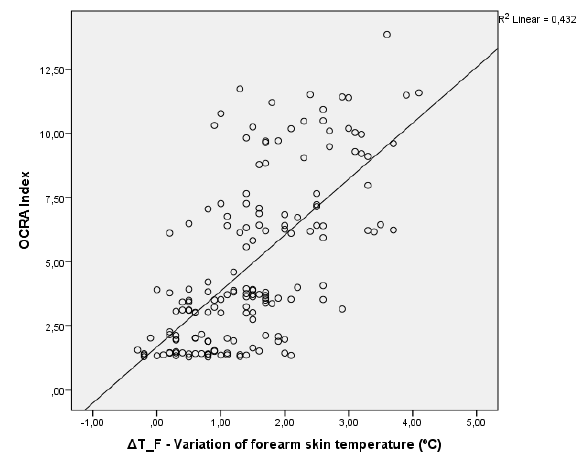
Figure 5. OCRA Index x Δ T_F–Variation of forearm skin temperature.